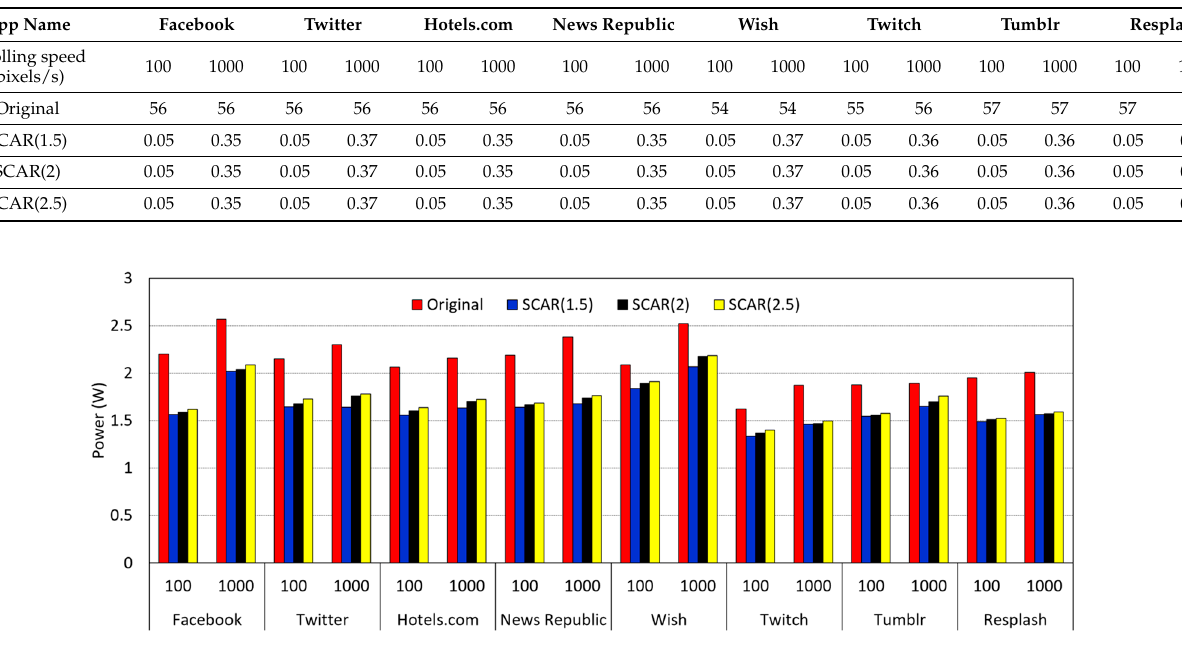
16 of 26 Table 2. Frame rate (fps) according to apps and scrolling speed. App Name